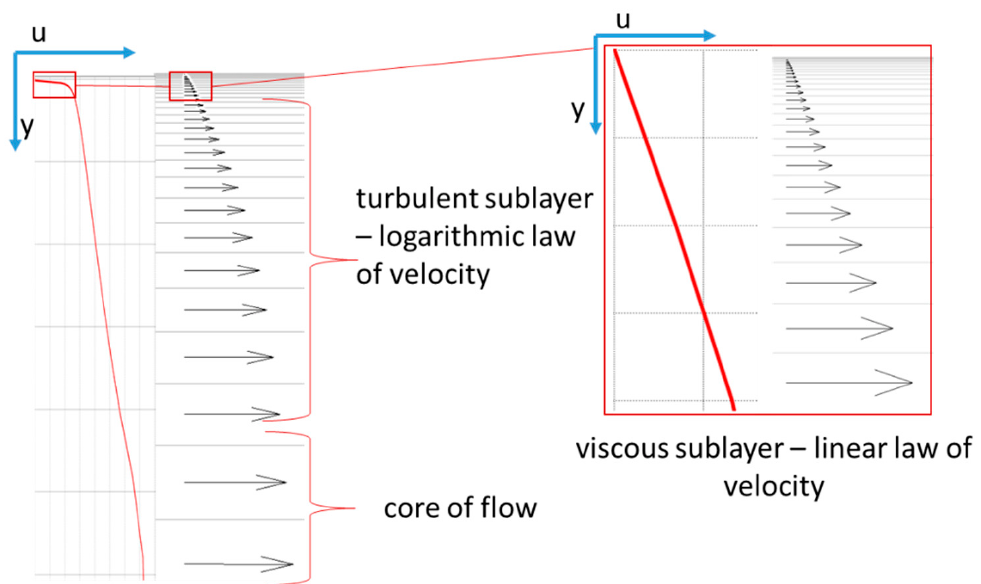
Figure 3. Velocity profile for fluid flow in a channel in natural scale.